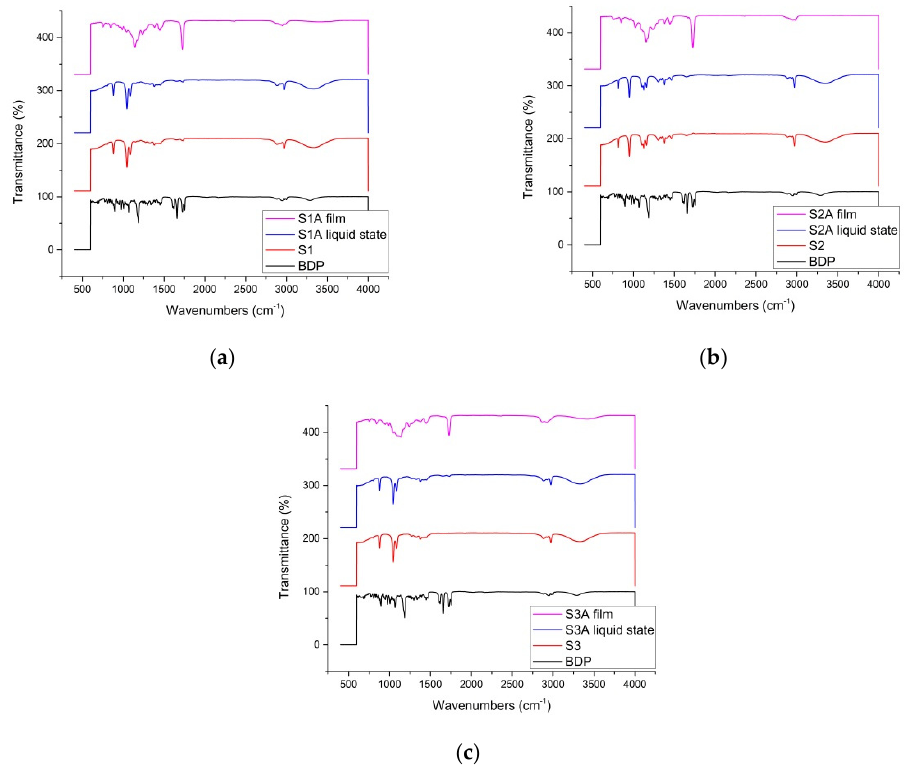
Figure 2. Comparative representation of FT-IR spectra obtained for BDP, ‘placebo’ FFS samples, and BDP-loaded samples in their liquid and dried (film) form provided for ( a ) samples S1/S1A, ( b ) S2/S2A and ( c ) S3/S3A.